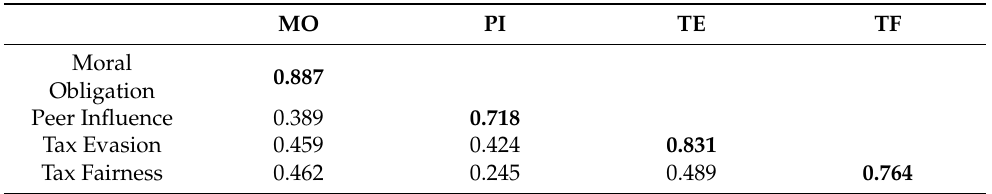
Table 2. Fornell and Larcker’s (1981) criteria.